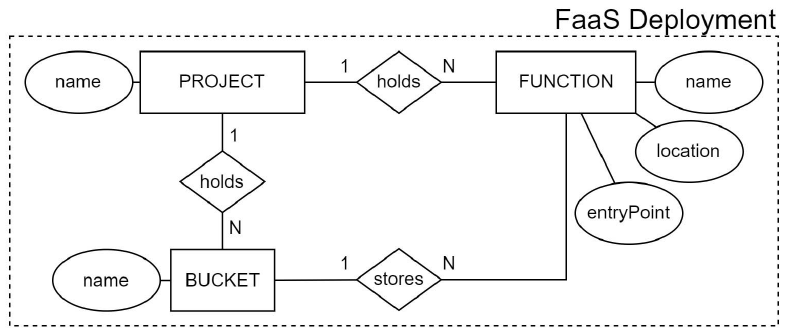
Figure 3. FaaS deployment